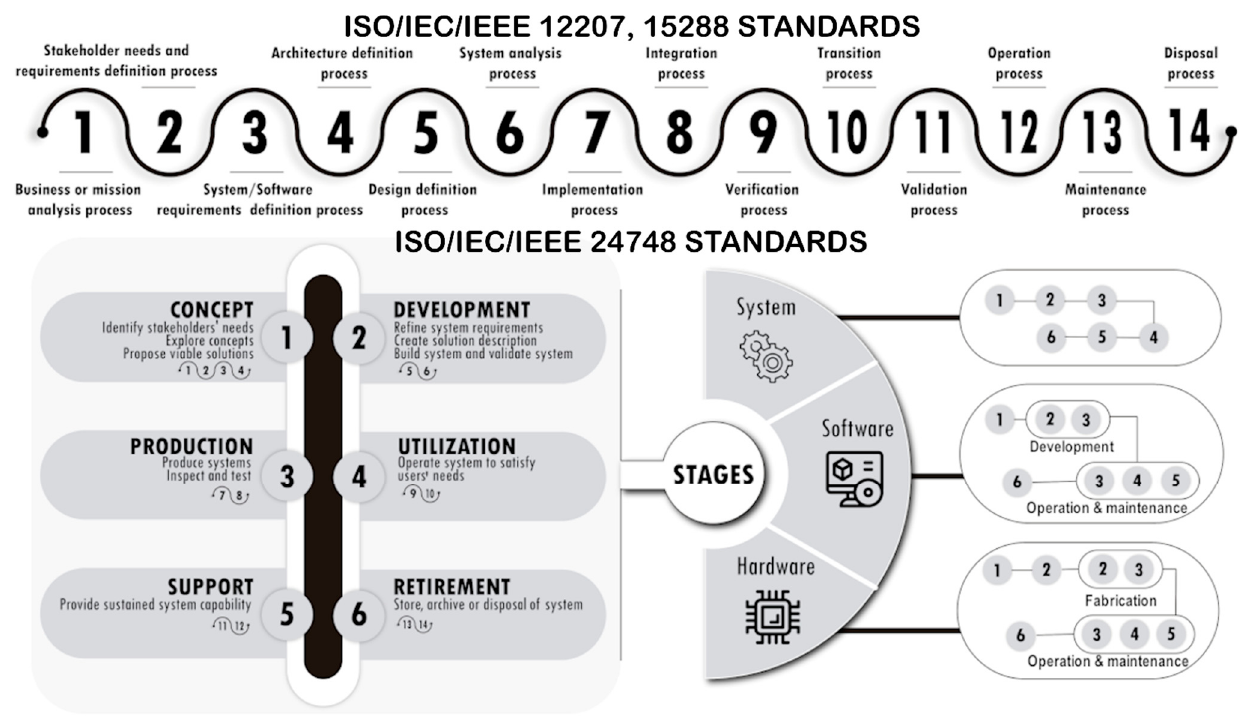
Figure 1. Summary of the stages and processes of the life cycle of software systems considered in the different reviewed ISO/IEC/IEEE standards [61,67,72,87,88].